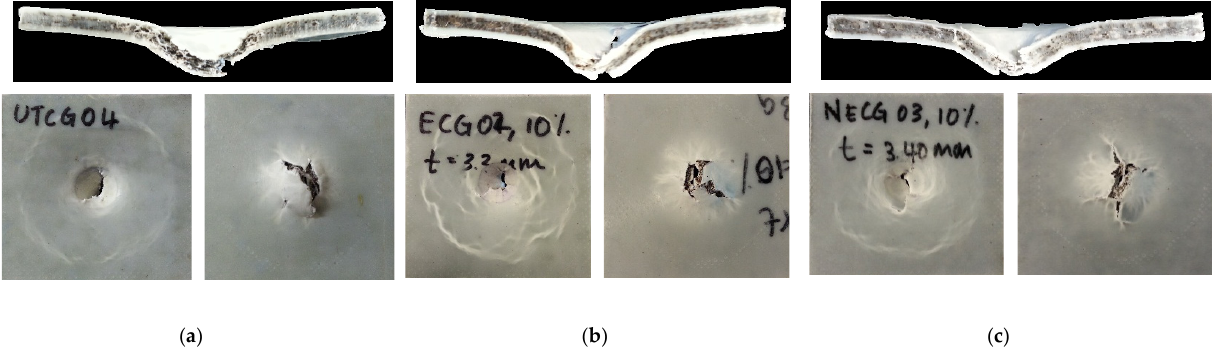
Figure 8. Photograph of fracture behavior of perforated samples ( a ) UGC, ( b ) OGC, ( c ) ONGC (10% particle loading).